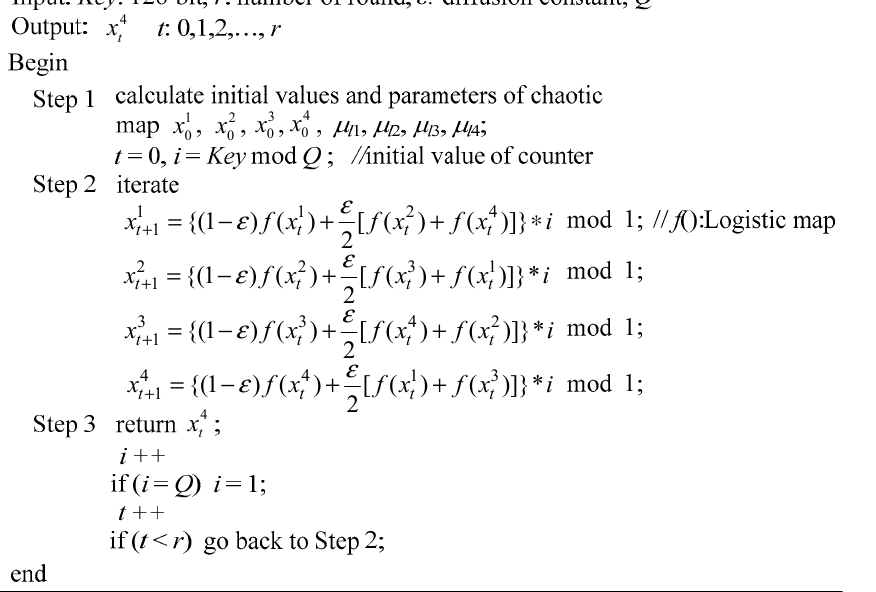
Figure 8. Simulation algorithm for improved CML. Figure 9 is the simulation results of the improved CML based on the logistic map, where p ( x t ) is the probability density, t is the time index and x t is the output. In these figures, we can find that the probability density of the original CML is improved.